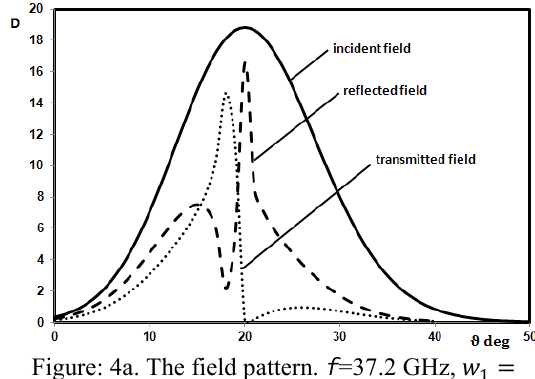
Figure: 4a. The field pattern. f =37.2 GHz,